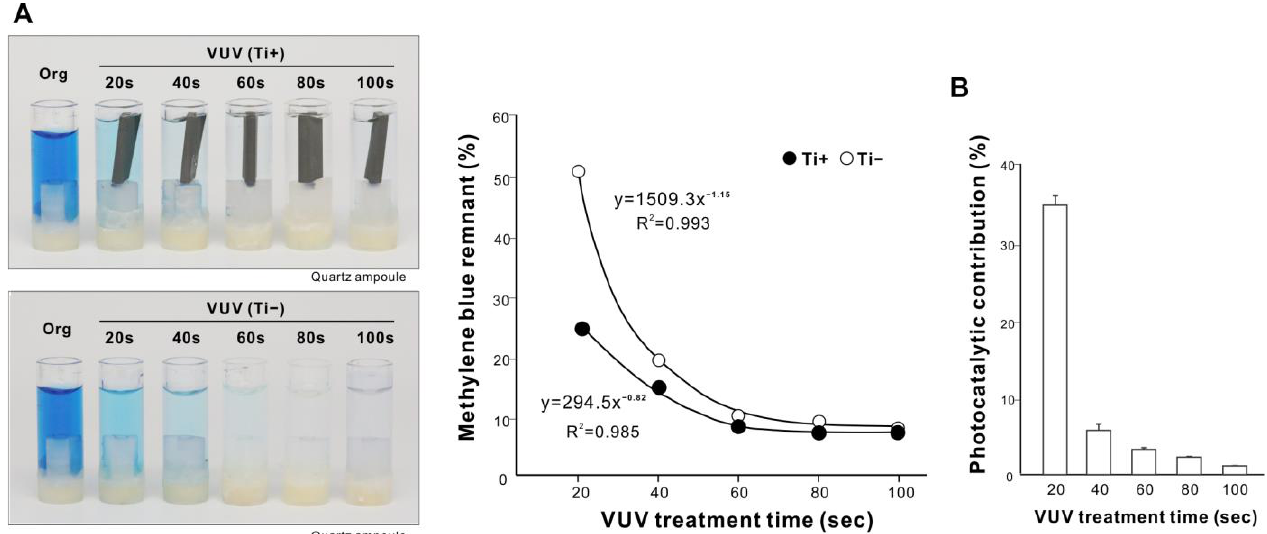
Figure 4. Dose dependency and optimization of VUV-mediated organic decomposition. ( A ) Photographs of the original methylene blue solution in a quartz ampoule together with solutions after VUV treatment for various treatment times from 20 to 100 s. The remaining methylene blue was quantified and plotted against UV treatment time; it showed a highly fitted, negative exponential curve. ( B ) Photocatalytic contribution (%) calculated as the difference in the amount of decomposed methylene blue with and without a microroughened titanium specimen.